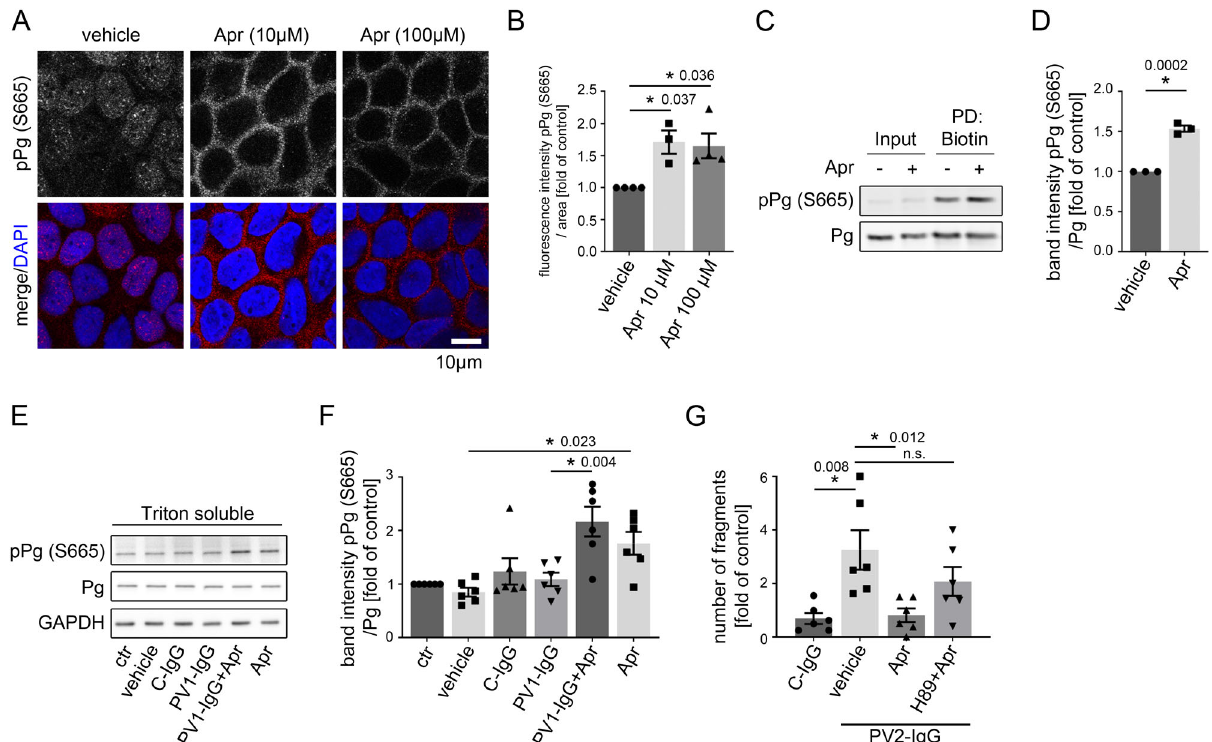
Fig. 4 | Apremilast increases phosphorylation of Pg at S665. A Immunostaining of phosphorylated Pg at S665 in HaCaT showed increased phosphorylation of Pg at S665 upon apremilast (10 and 100 µ M) treatment. Representative of n =4. Scale bar=10 µ m. B Quanti fi cationcon fi rmssigni fi cantstrongerpPG(S665)stainingalong keratinocyte cell borders ( n =4). Bars indicate mean value ±SEM. C Biotinylation assayrevealhigherlevelsofpPg(S665)atthecellmembraneofHaCaTkeratinocytes after apremilast (10 µ M) compared to control. Representative of n =3. D Quanti fi cation of the biotin pulldown of the biotinylation assay. Representative